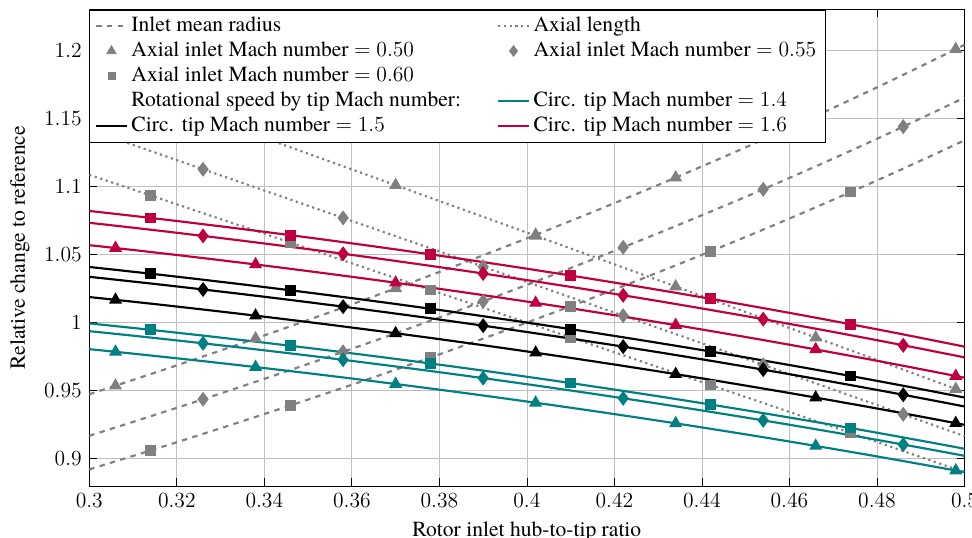
Figure 11. Relative changes in flow path parameters over the hub-to-tip ratio in the fan stage, depending on the inlet and circumferential Mach numbers.